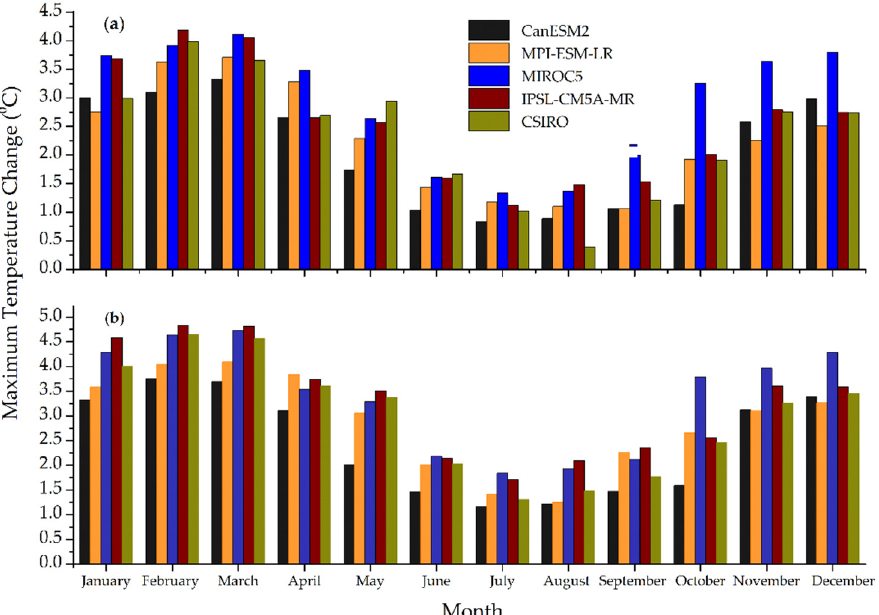
Figure 10. Changes in the monthly maximum temperature for the far future period from 2071–2100 with respect to the baseline obtained with: ( a ) RCP4.5; and ( b ) RCP8.5.